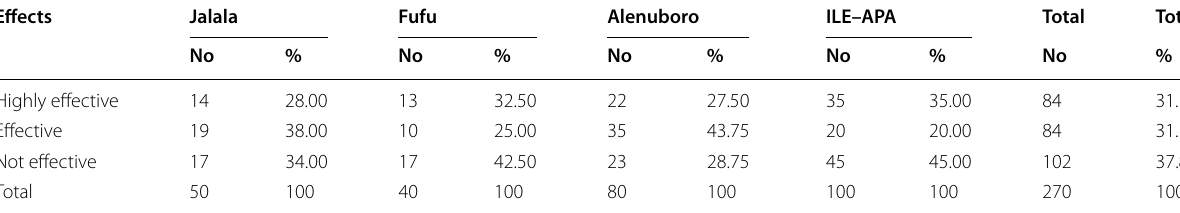
Table 8 The effects of mitigation on climate change